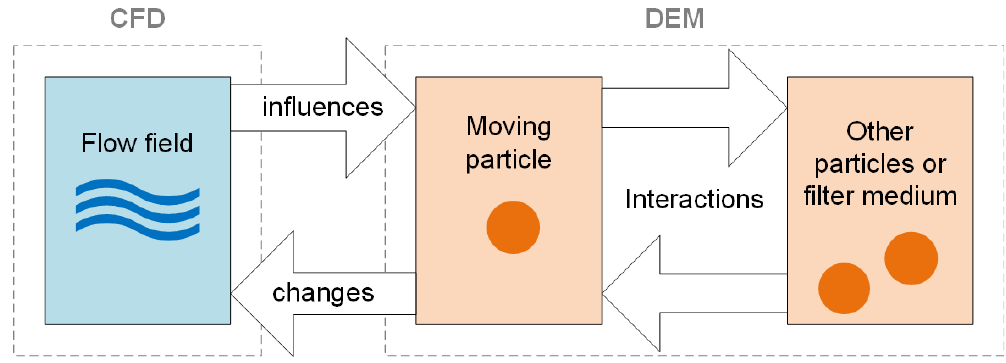
Figure 1. Specification of the 4-way CFD-DEM coupling. Each interaction is illustrated by an arrow.